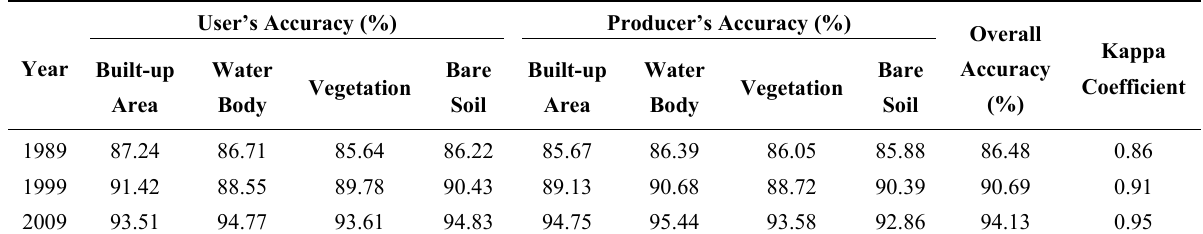
Table 3. Accuracy assessments of the land cover